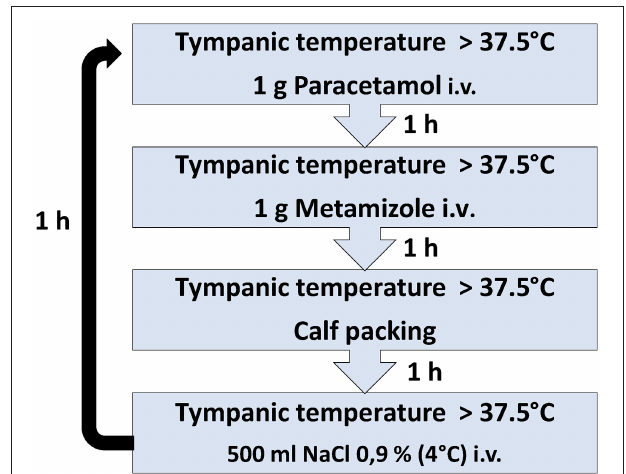
FIGURE 1 | The SOP includes a sequence of four antipyretic interventions with close measurement of body